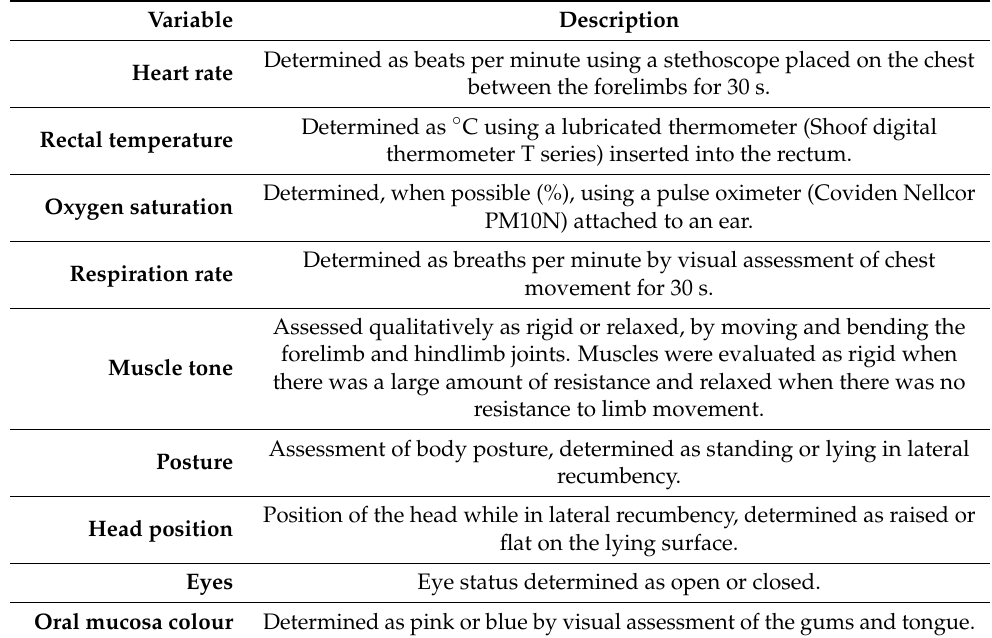
Table 1. Physiological variables evaluated during (2 and 8 min after application) and after the 10 min squeeze to check initial health, stability during the squeeze and recovery afterwards. Variable Description Determined as beats per minute using a stethoscope placed on the Heart rate